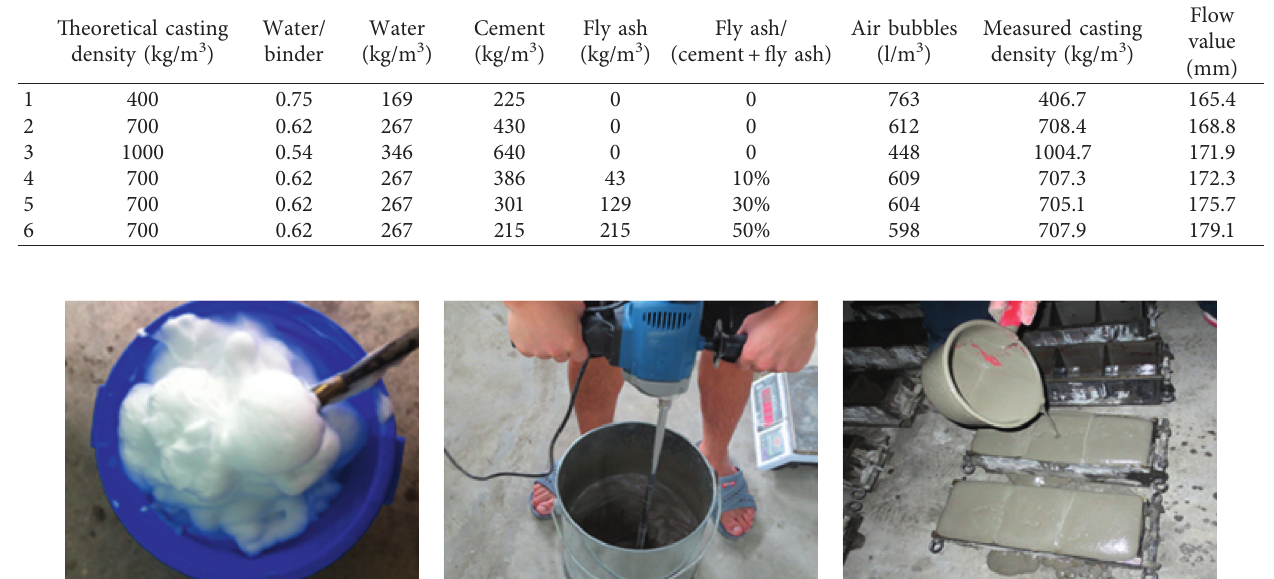
Table 1: Mix proportions and major parameters of the foamed concrete.